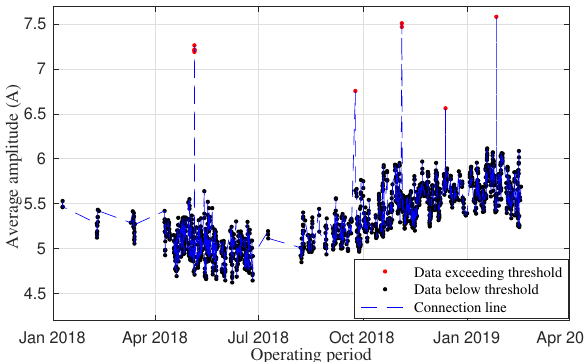
Figure 2. An example of degradation